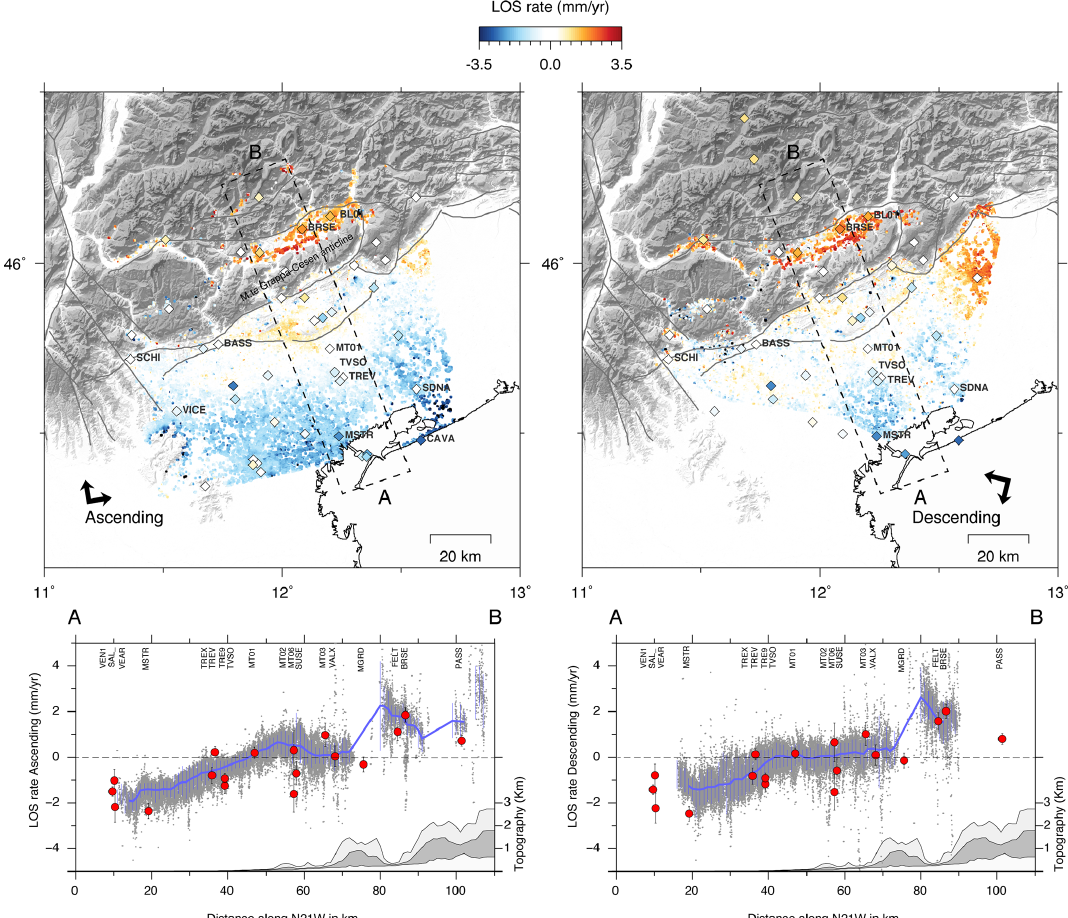
Figure 4. Top panels: InSAR line-of-sight (LOS) velocities (after the ramp removal; see Sect. 3.3 for details) for the ascending (left) and descending (right) orbits, with negative (blue) and positive (red) values indicating increasing and decreasing distances between the Earth’s surface and the satellite. Colored diamonds indicate the three-dimensional GPS velocities projected along the SAR LOS directions. Bottom panels: InSAR and GPS LOS velocities (red circles with 1 σ error bars in gray) along the A–B cross section (dashed box) for the ascending and descending orbits, respectively. The blue line indicates the median value of the InSAR data along the cross section, given the minimum number of 50 SAR pixels in each bin of 1km, and the light bars represent the data dispersion for each